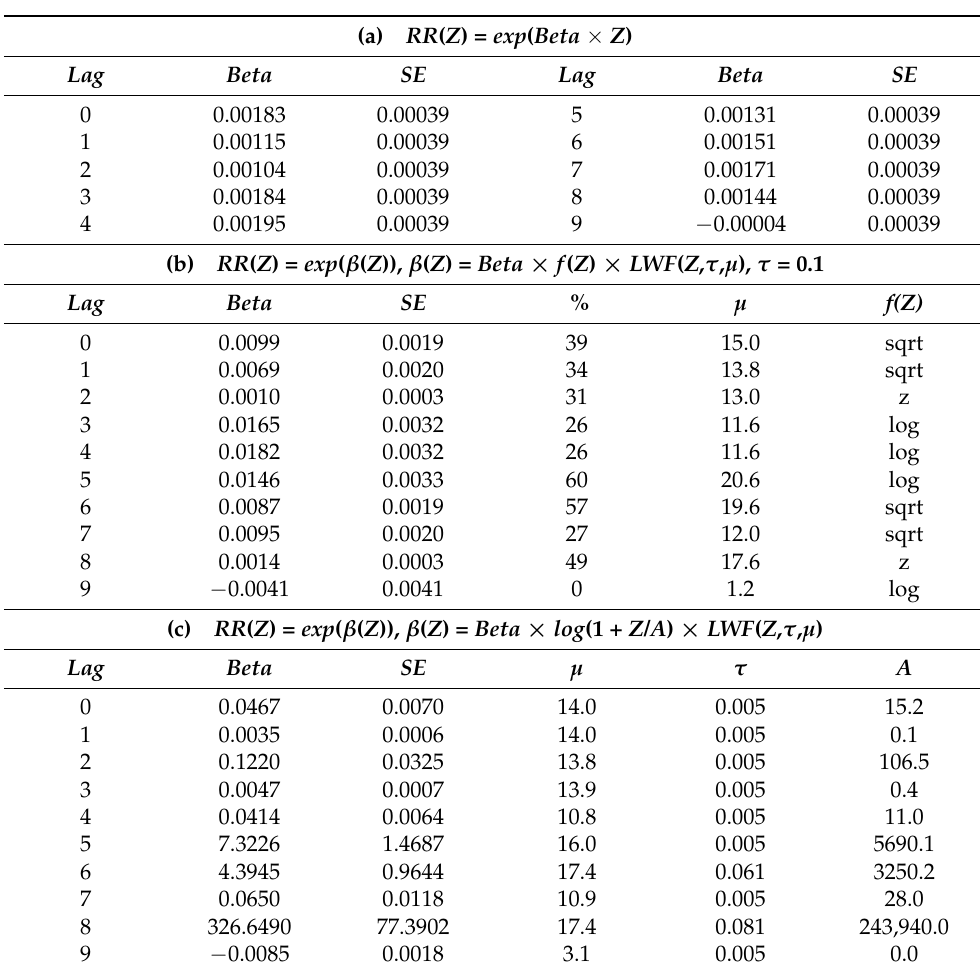
Table 1. The estimations obtained by the case-crossover approach: ( a ) no transformation, ( b ) trans- formation with f ( Z ) ( =Z , log ( Z ), or sqrt ( Z )), and ( c ) transformation with f ( Z ) = log (1 + Z / A ). The transformation is submitted into the models in the form f ( Z ) × LWF ( Z ) to represent concentrations. ED visits for all respiratory conditions. Edmonton, Canada, 1992–2002.